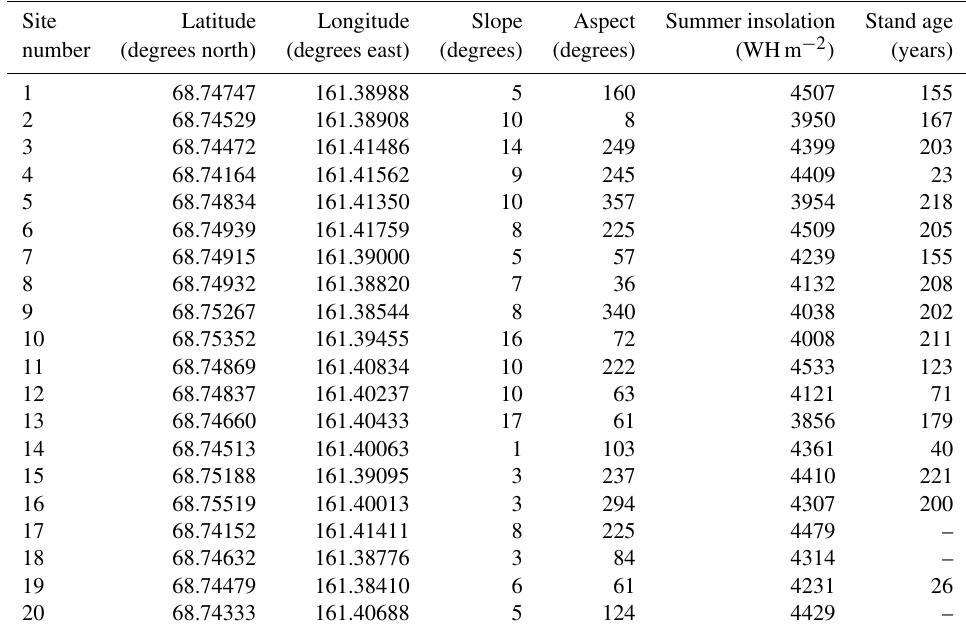
Table 1. Site characteristics. All sites were in forested areas except no. 17 (riparian); site no. 18 (alas) had few scattered trees located along one end of the sampling